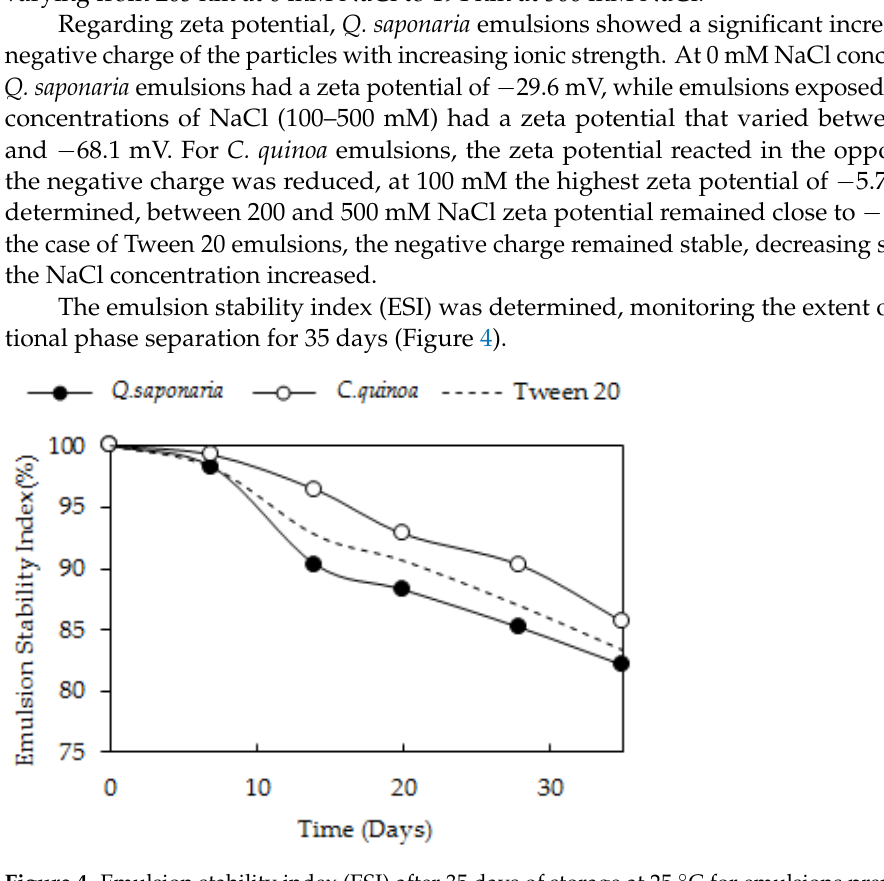
Figure 5. Fatty acids release curves generated during intestinal digestion for emulsions generated with ( ● ) Quillaja saponaria , ( ○ ) Chenopodium quinoa , or (--) Tween 20 as emulsifier. 4. Discussion Saponins from Q. saponaria and C. quinoa were effective for the formation of astaxan- thin enriched oil-in-water emulsions. The smallest mean particle size was obtained using